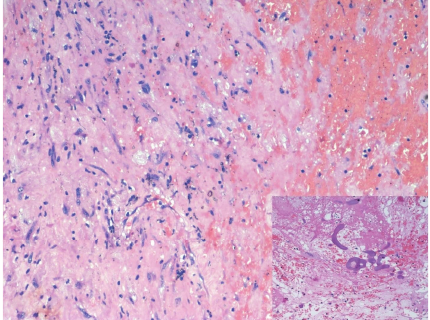
Figure 3: Photomicrograph showing spindle cell neoplasm with cellular atypia and stromal changes (H&E 200x) (inset showing calcification).